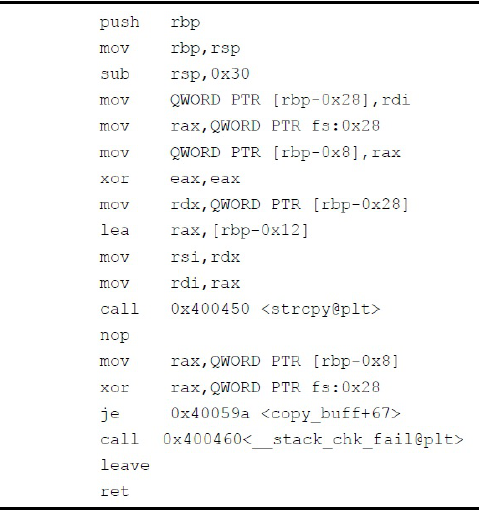
Figure 29. Disassemble of copy_buff